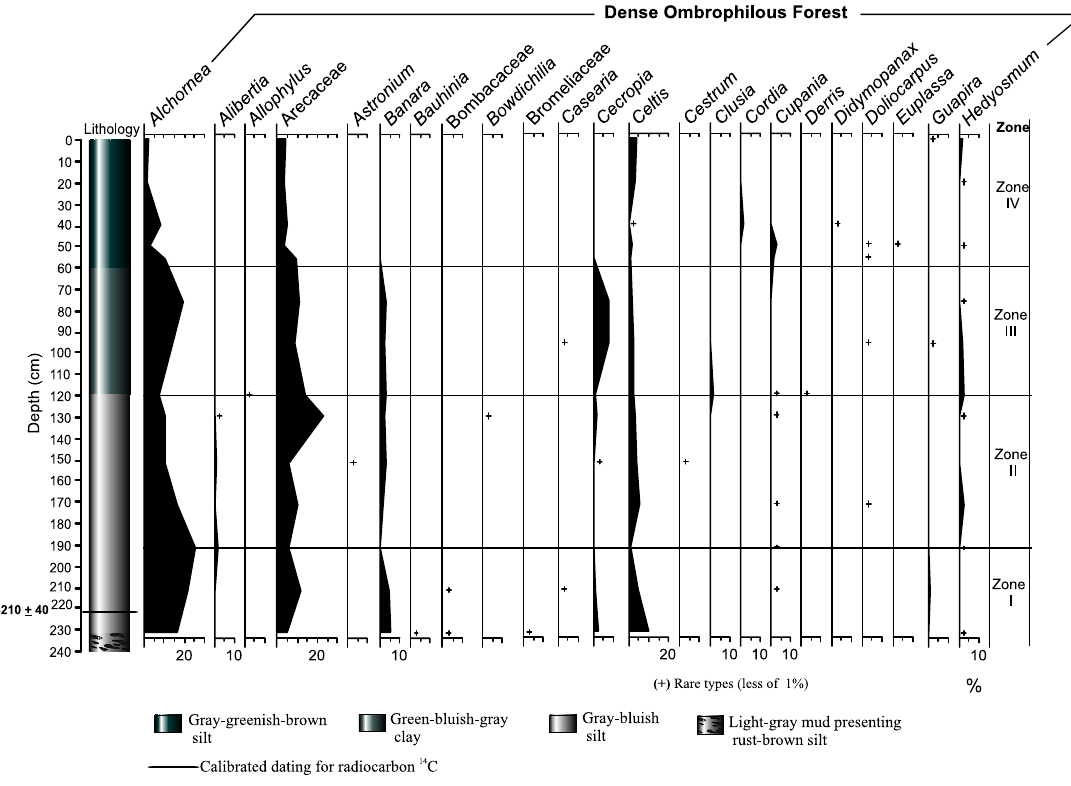
Fig. 3 – Percentage palynodiagram of the pollen types grouped into the Dense Ombrophilous Forest vegetation.